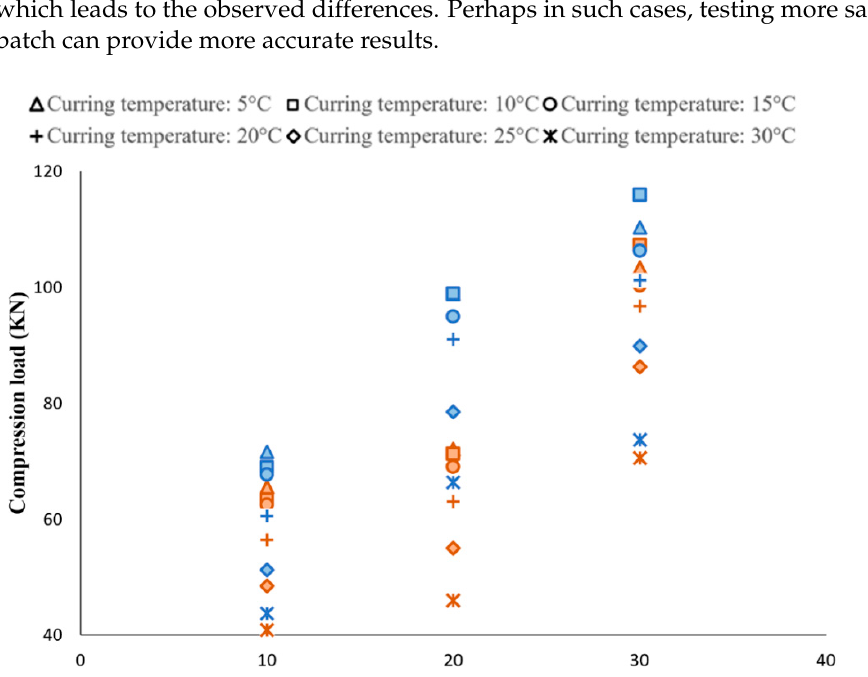
Figure 6. Mechanical test results for all batches of concrete specimens.